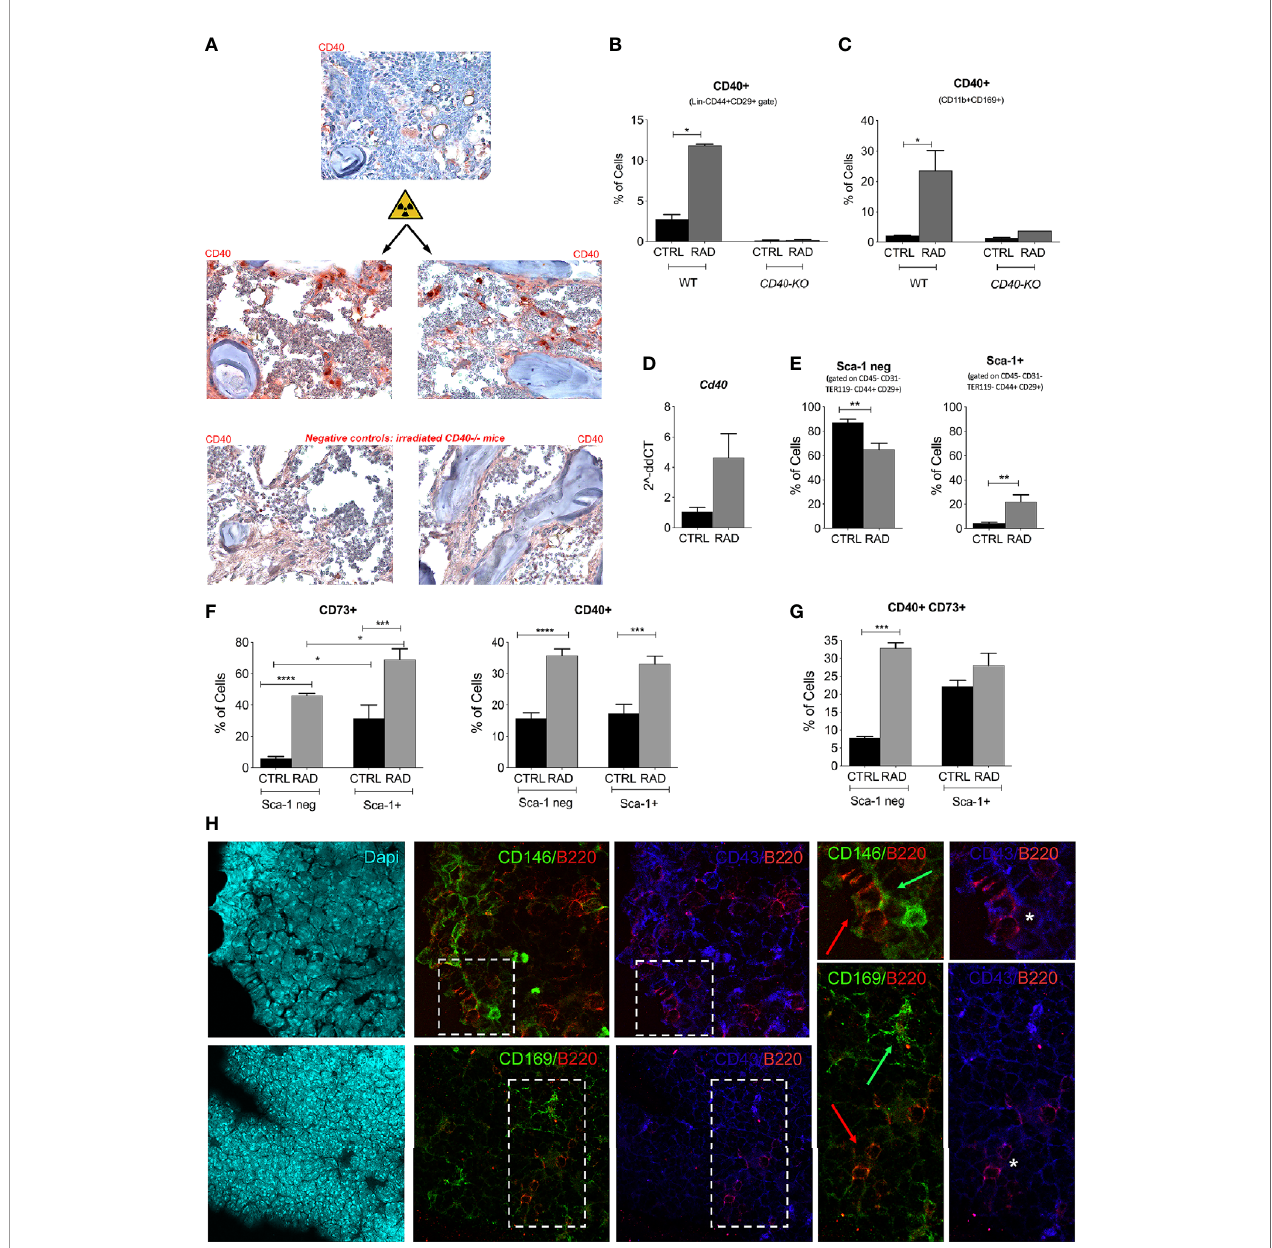
FIGURE 2 | Expression of CD40 in the BM microenvironment. (A) Representative image of CD40 IHC staining in the femurs and tibias of WT mice harvested 7 days post-irradiation. (B) FACS analysis showing the up-modulation of CD40 on BM-MSC isolated from irradiated (RAD) and non-irradiated (CTRL) BALB/c (CTRL n=5; RAD n=4) and Cd40-KO mice (CTRL n=5; RAD n=2). *p < 0.05, Mann-Whitney test. (C) FACS analysis showing the up-modulation of CD40 on CD169+ cells isolated from irradiated (RAD) and non-irradiated (CTRL) BALB/c (CTRL n=5; RAD n=4) and Cd40-KO mice (CTRL n=5; RAD n=2) *p < 0.05, Mann-Whitney test. (D) RT-PCR analysis showing the expression of CD40 on primary BM-MSCs (not expanded in vitro ) puri fi ed from BM at days 4 and 7 post-radiation and compared to basal expression. *p < 0.05, Mann-Whitney test (n=5/group). (E) Cumulative FACS analysis showing the frequency of Sca-1+ and Sca-1- BM-MSCs (CD29+CD44+CD45-Ter119-CD31-CD117-CD34- gate) in irradiated mice (**p < 0.005; Student t test; n=8 for controls and n=10 for irradiated mice). (F) Cumulative FACS analysis showing the frequency of CD73+ and CD40+ BM-MSCs within the Sca-1+ and Sca-1- gate (n=8 for controls and n=10 for irradiated mice). *p < 0.05, **p < 0.005, ***p < 0.001, ****p < 0.0001, Tukey ’ s multiple comparisons using a one-way ANOVA. (G) Cumulative FACS analysis showing the frequency of CD40+CD73-, CD40+CD73+, and CD40-CD73+ BM-MSCs in irradiated (RAD) vs non-irradiated mice (CTRL). n=8 for controls and n=10 for irradiated mice; **p < 0.005, ***p < 0.001, ****p < 0.0001, Tukey ’ s multiple comparisons using a one-way ANOVA. (H) Triple marker confocal microscopy analysis showing CD146+ (green, panels above) or CD169+ (panels below) elements in B220+ (red) and CD43+ (blue) cells. Arrows in the two enlargements indicate the spatial localization of B220+ (red arrow) and CD146+ (green arrow panel above) or CD169+ (green arrow panel below) cells. CD43+B220+ double positive cells (asterisk) are B cell precursors. The analysis indicated that B220+ (in part CD43+) exhibits preferential contact with CD146 but not CD169+